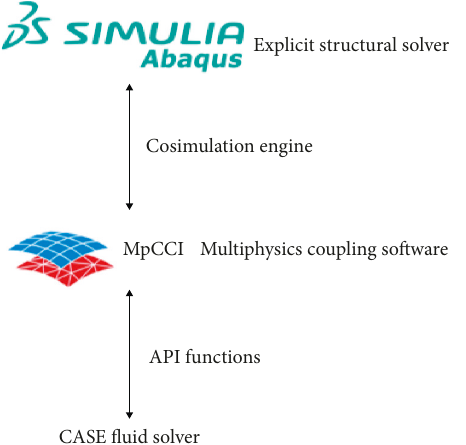
Figure 1: Partitioned FSI